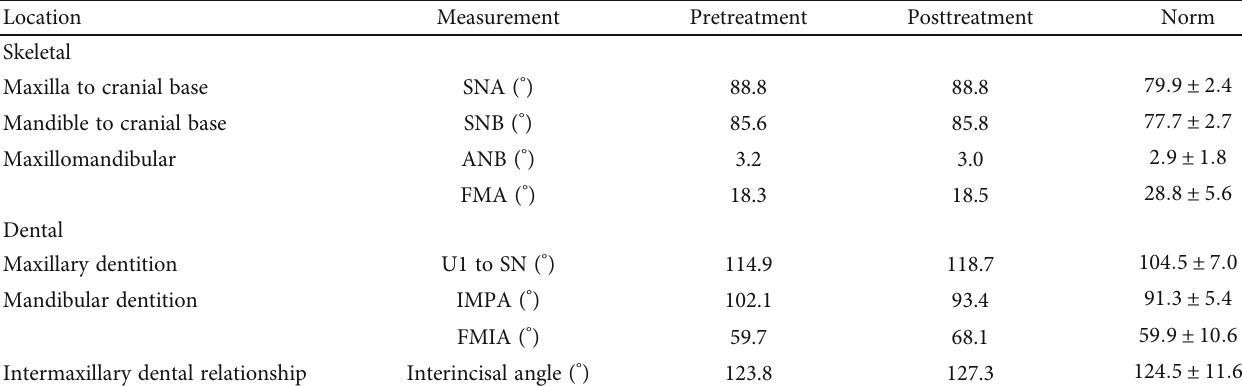
Table 1: Superimposition of pre- and